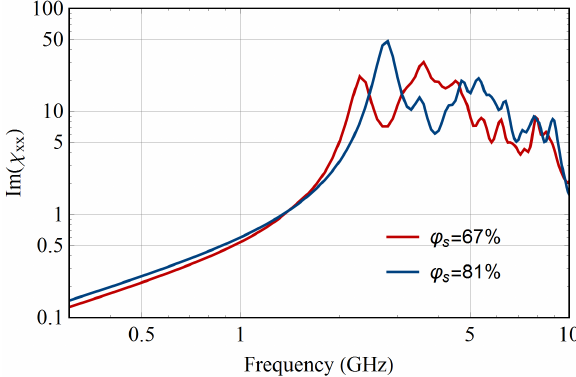
Figure 11. Disordered assemblies of nanoplatelets. Im( χ xx ) spectra for two high surface contents ϕ s = 67% and ϕ s =